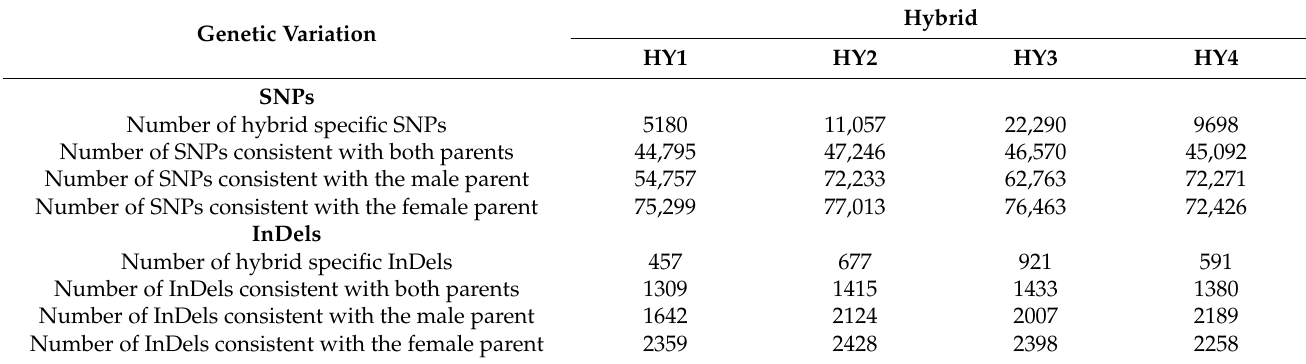
Table 2. The genetic variations between cabbage hybrids and their parents.